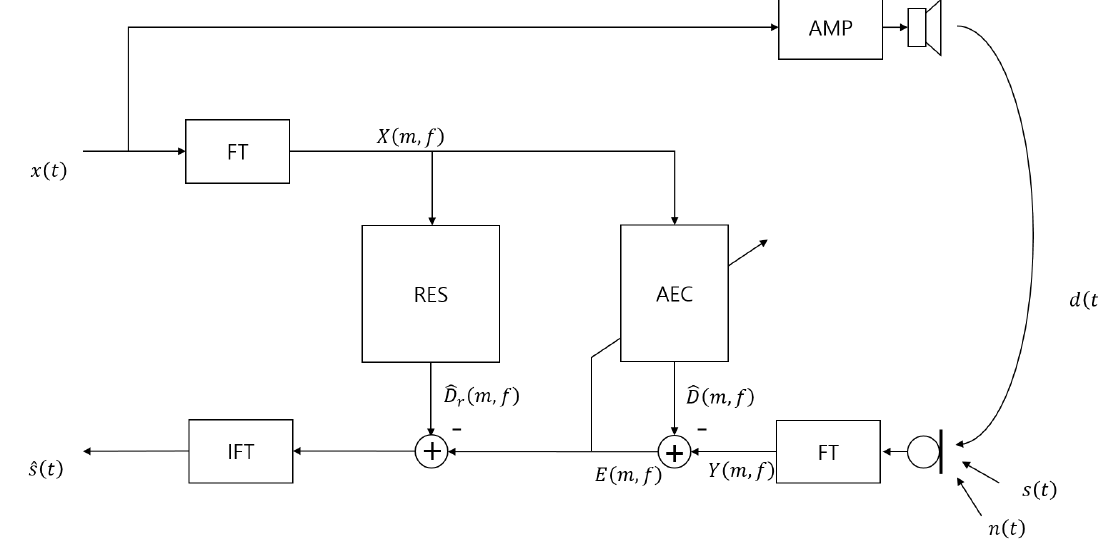
Figure 1. General block diagram of the acoustic echo cancellation system with residual echo